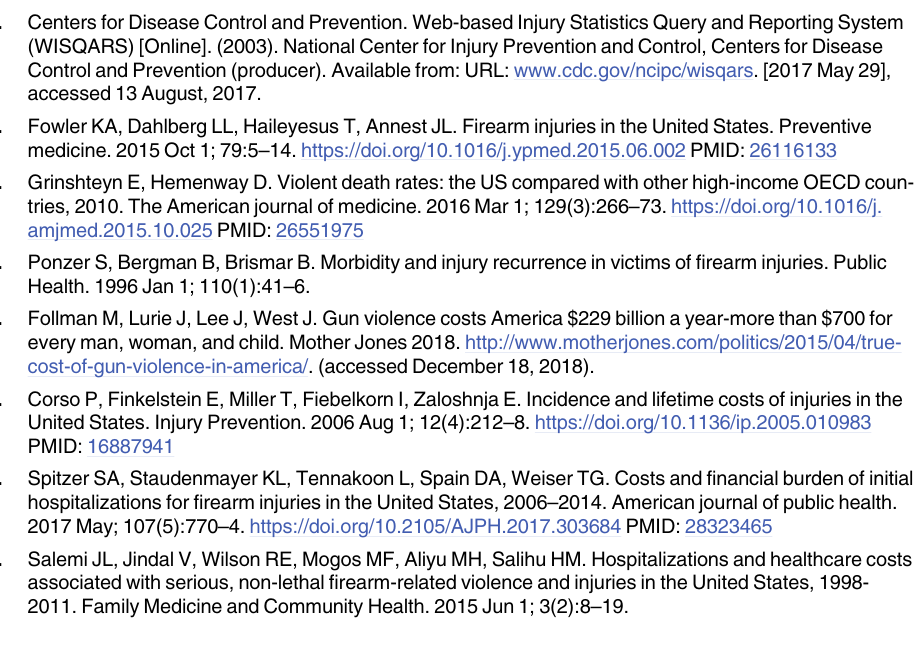
S1 Table. All single level diagnosis CCS categories with inclusion status for readmission analysis as evaluated by three independent authors. S2 Table. Cox proportional hazards model